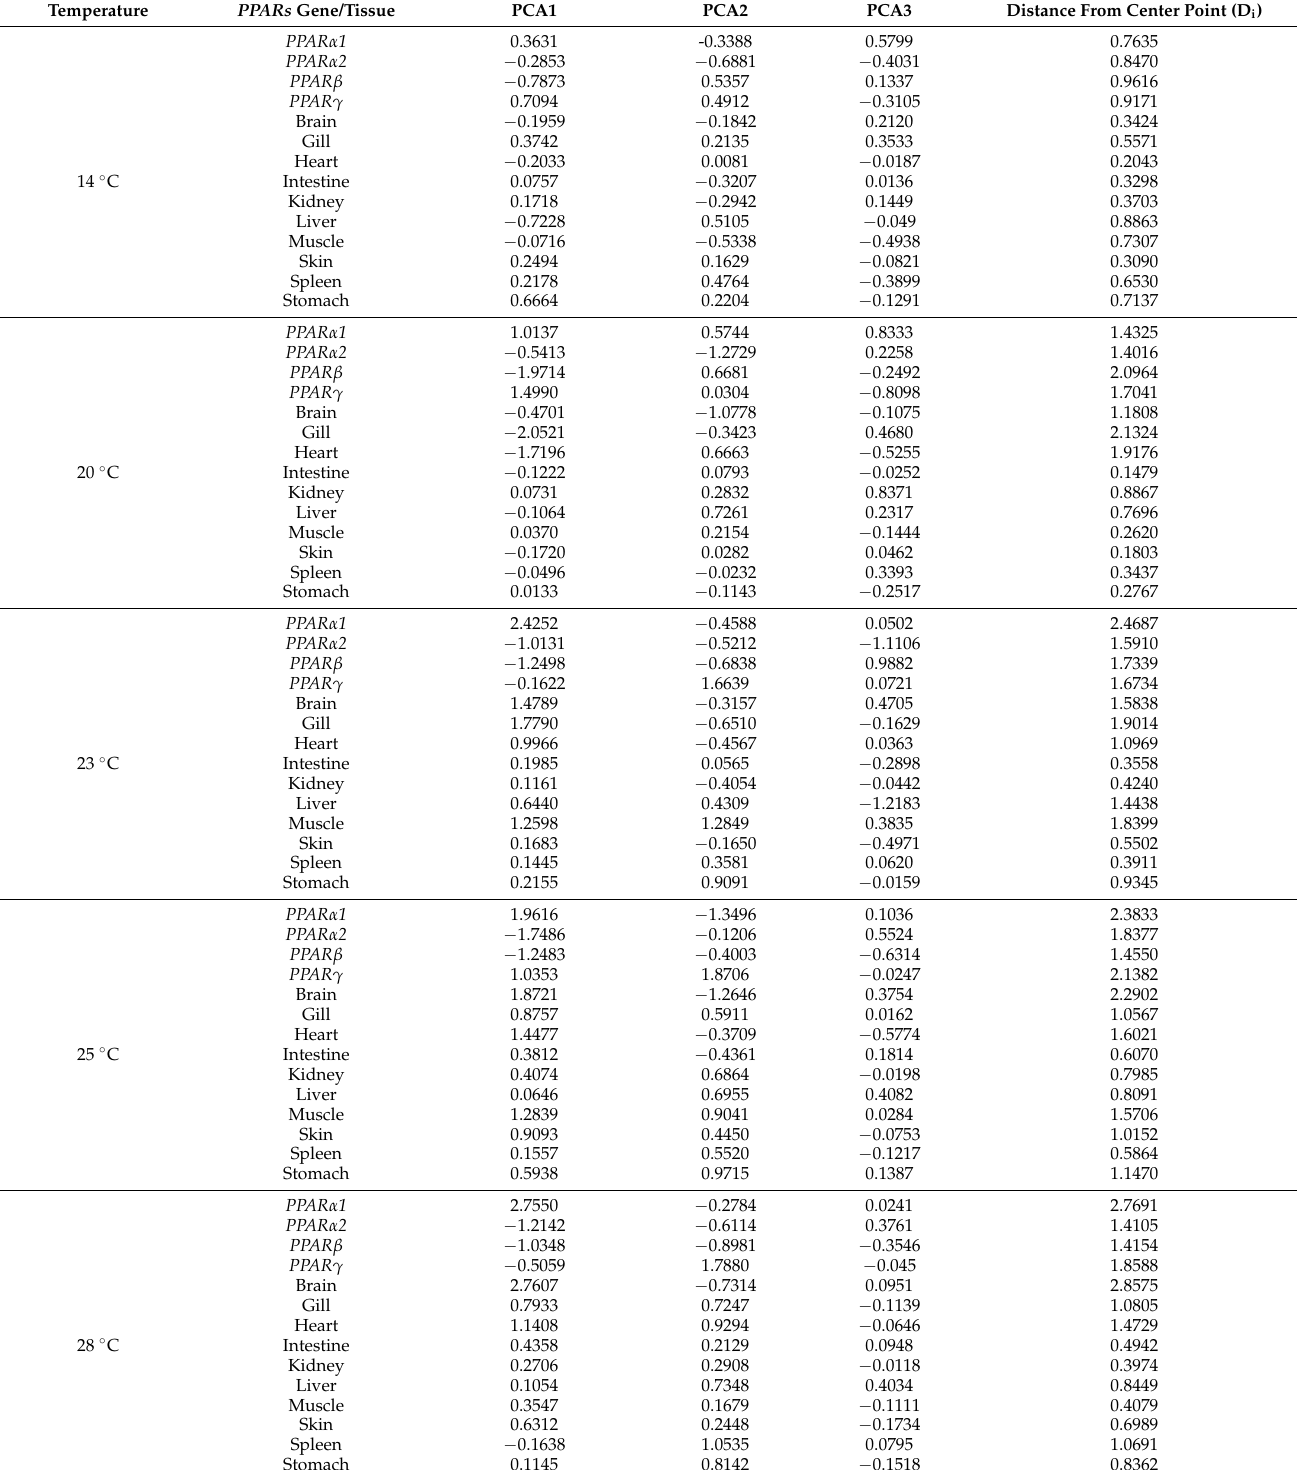
Table 3. GGE biplot analysis of PPAR genes in different tissues at different